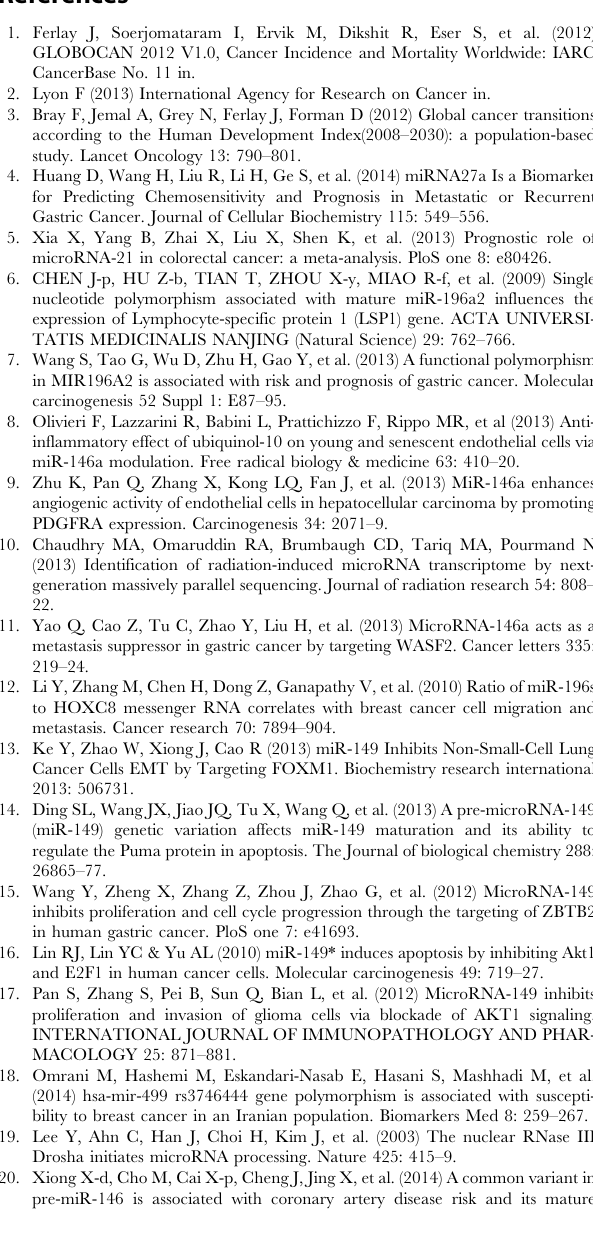
Table S2 The original data for the meta-analysis. Table S3 The association of mirna polymorphisms with DFS and